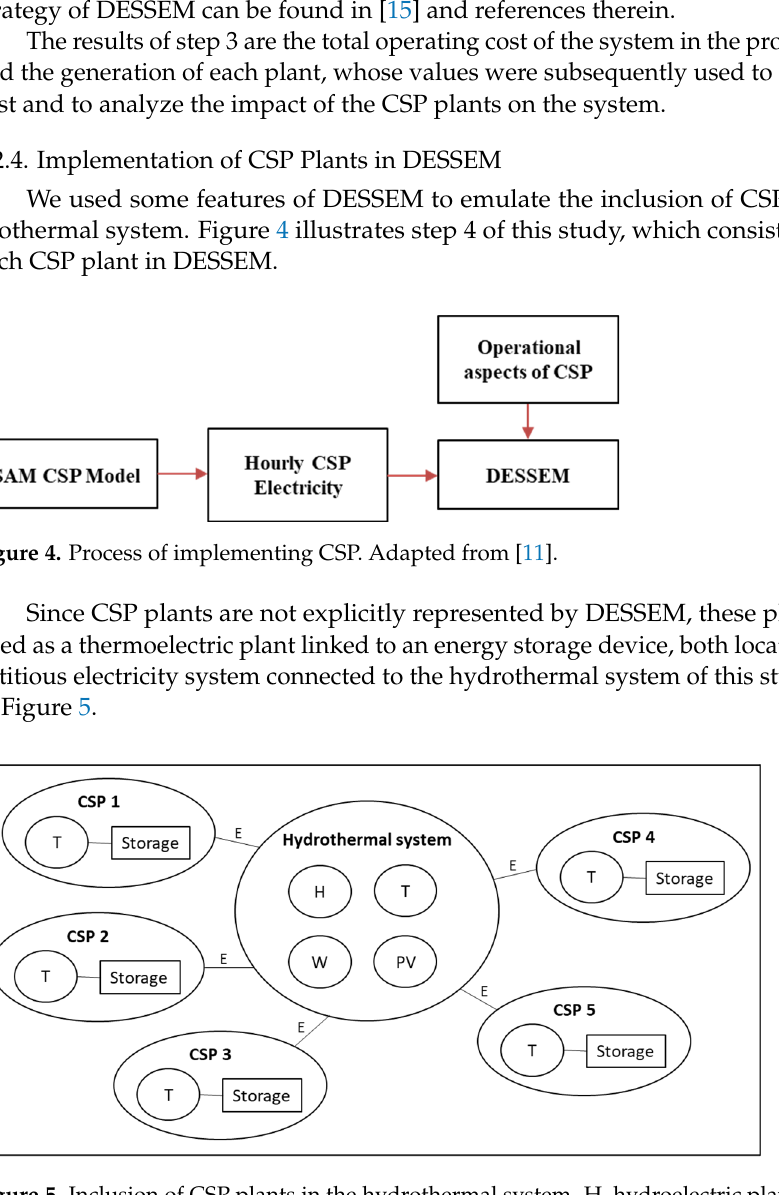
Figure 5. Inclusion of CSP plants in the hydrothermal system. H, hydroelectric plants; T, thermoelectric plants; W, wind farms; PV, solar PV power plants; E, energy exchange.